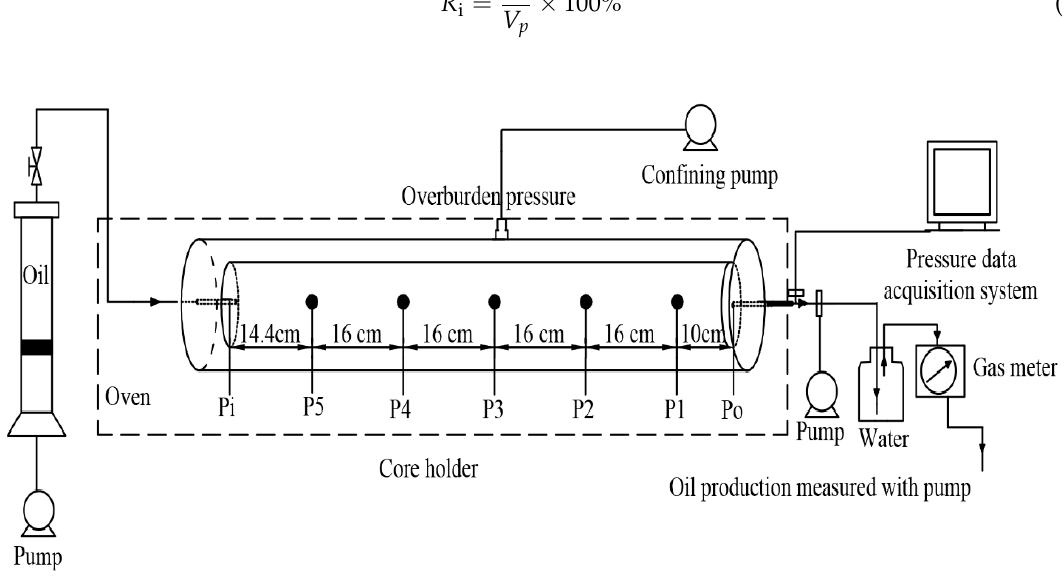
Figure 2. Schematic diagram of the experimental setup.